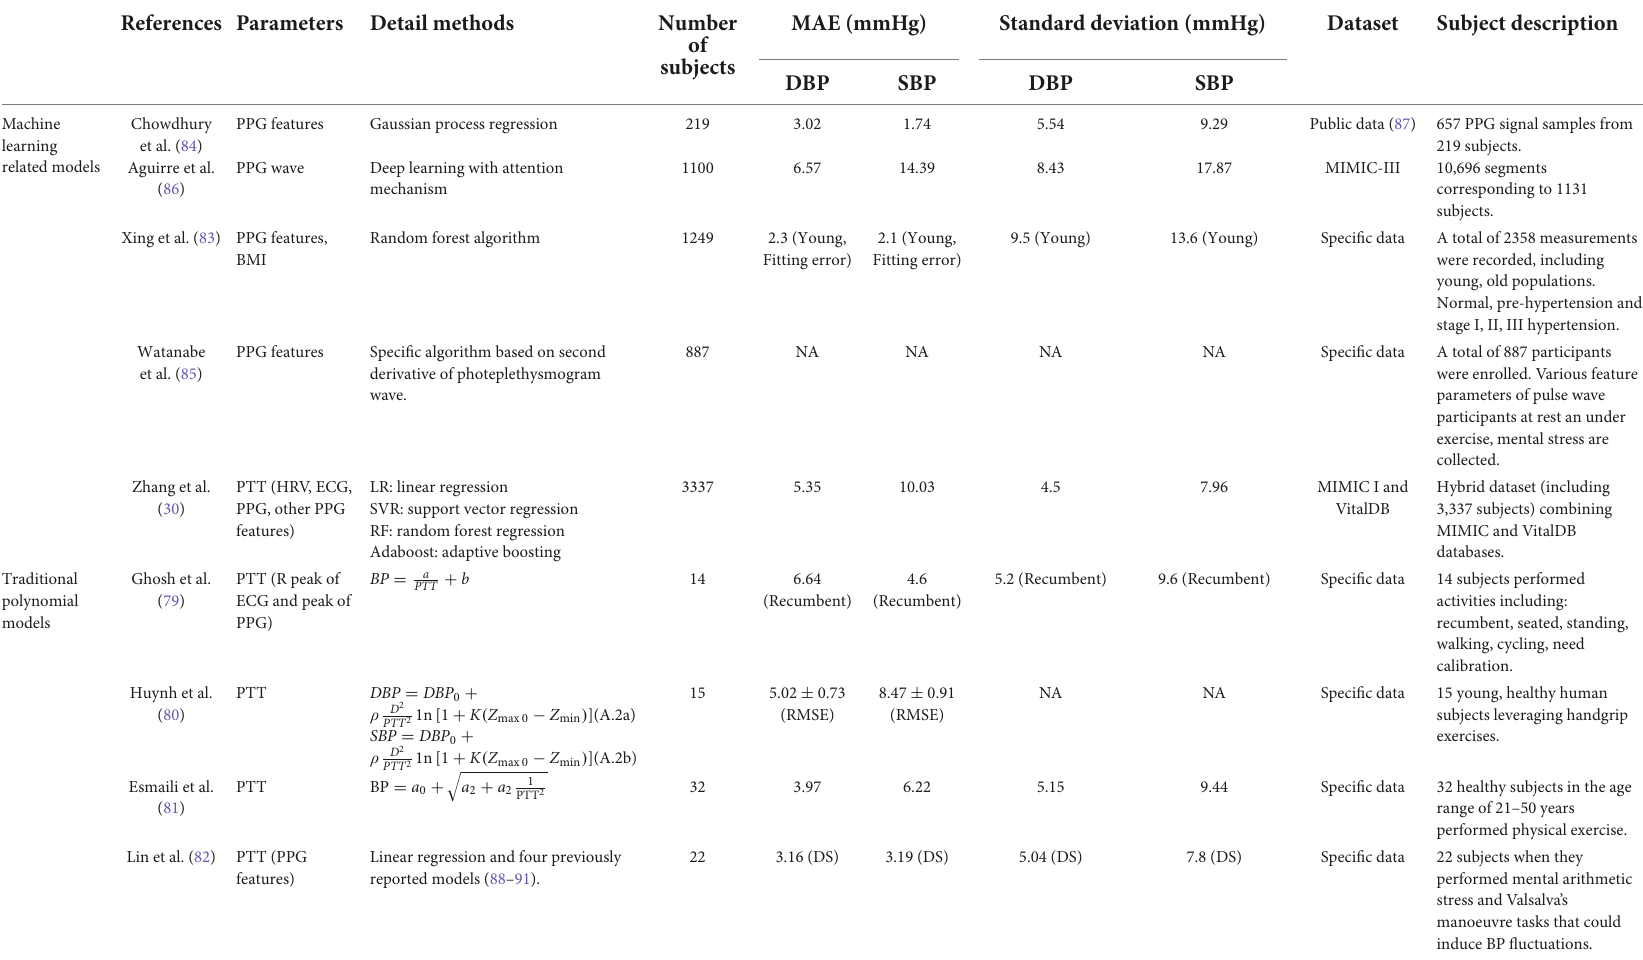
TABLE 2 The machine learning models and traditional polynomial